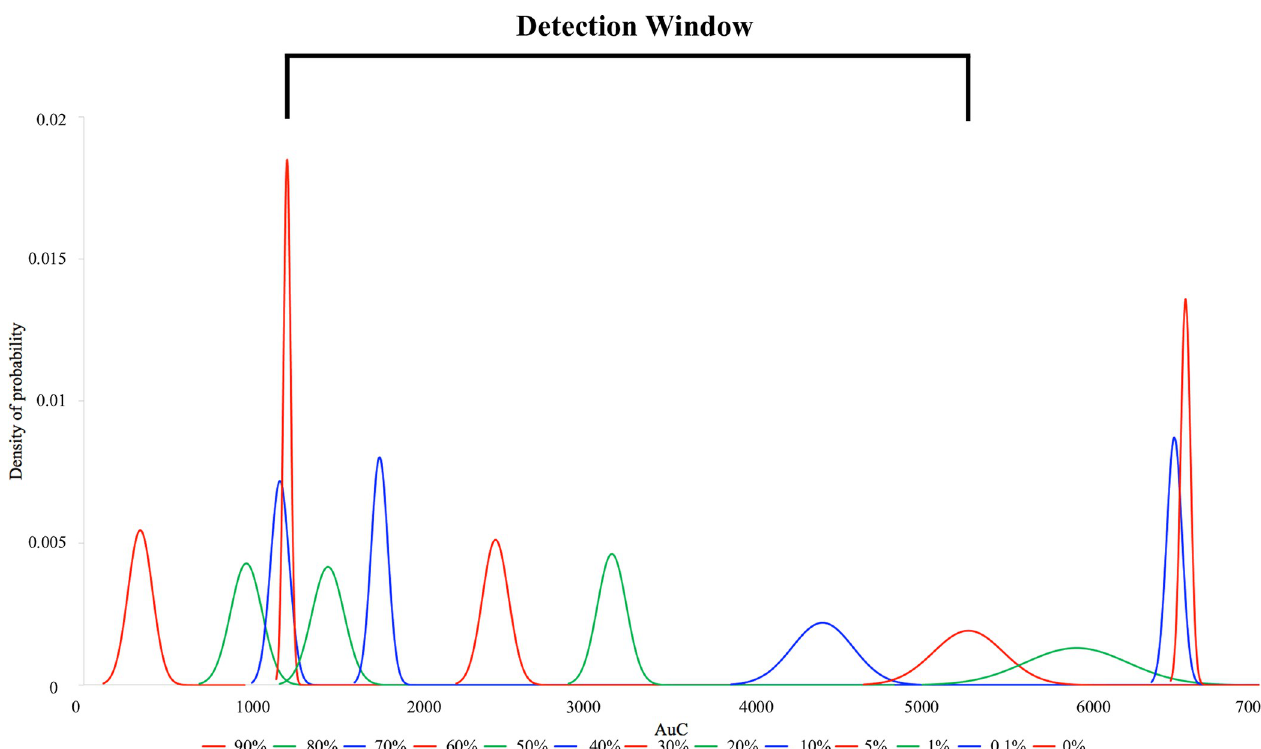
Fig 8. Example of calculation of the detection window for the EpiMelt MGMT assay. The bell-shaped Gaussian distribution for each control mix was calculated and only in the range where the bel-shaped density plots did not overlap within 2SD (marked in black) was considered the assay specific detection window and used for estimation of the methylation levels.